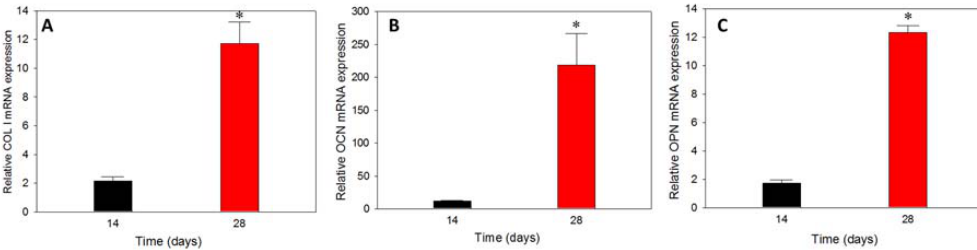
Figure 11. The relative (to day 0) mRNA expression of COL I ( A ), OCN ( B ) and OPN ( C ) of rBMSCs ‐ seeded hybrid scaffolds cultured in vitro for 14 and 28 days by rea ‐ time qPCR analysis. * p < 0.01 compared to day 14.